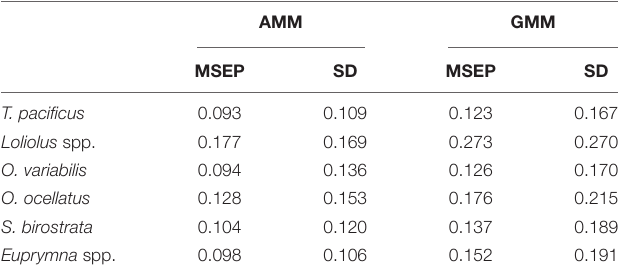
TABLE 4 | Comparison of the mean square errors of prediction (MSEP) and their standard deviations (SDs) for arithmetic mean method (AMM)- and